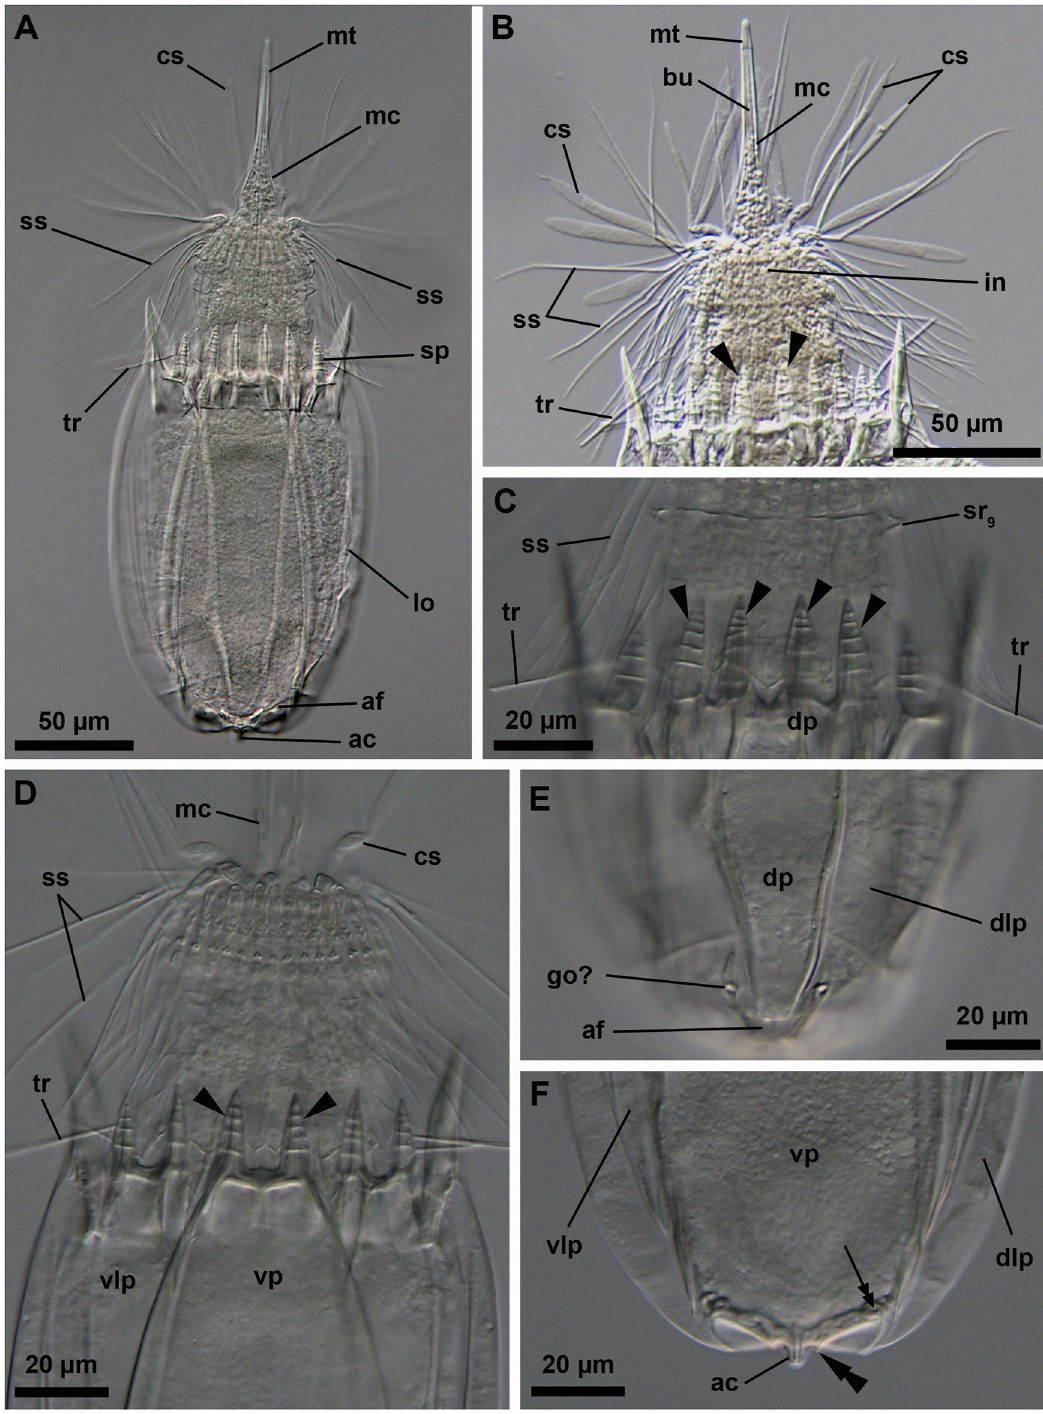
Fig 18. Light micrographs of the allotypic adult male of Scutiloricus hugoi gen. et sp. nov. Anterior faces up in all aspects. (A) Overview of the extended specimen, dorsal view. (B) Anterior region of the body, ventral view. (C) Close-up of the anterior spikes of the dorsal and dorsolateral plates. Note the fenestrated aspect of the anterior spikes (arrowheads). (D) Introvert, neck and anterior region of the abdomen; ventral view. (E) Posterior region of the lorica, dorsal view. Note the putative gonopores (go?) located in the posteriormost region of the dorsolateral plates. (F) Posterior region of the lorica, ventral view. Double-headed arrow points to large pore (gland outlet?) situated in the posterior region of the ventral plate. Double arrowheads indicate an anal field spur.